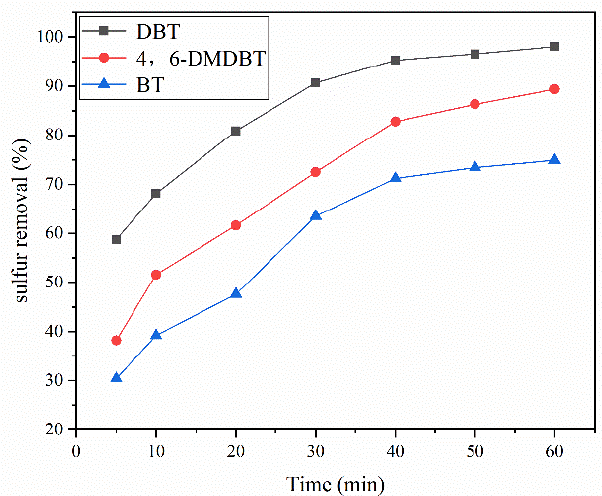
Figure 10. HPMo removal efficiency for different sulfides. Experimental conditions: temperature, 0 °C; initial sulfur concentration, 500 ppm; catalyst dosage, 2.5 wt.% of n -octane; ozone dosage, 0.1 g/h; reaction time, 60 min.